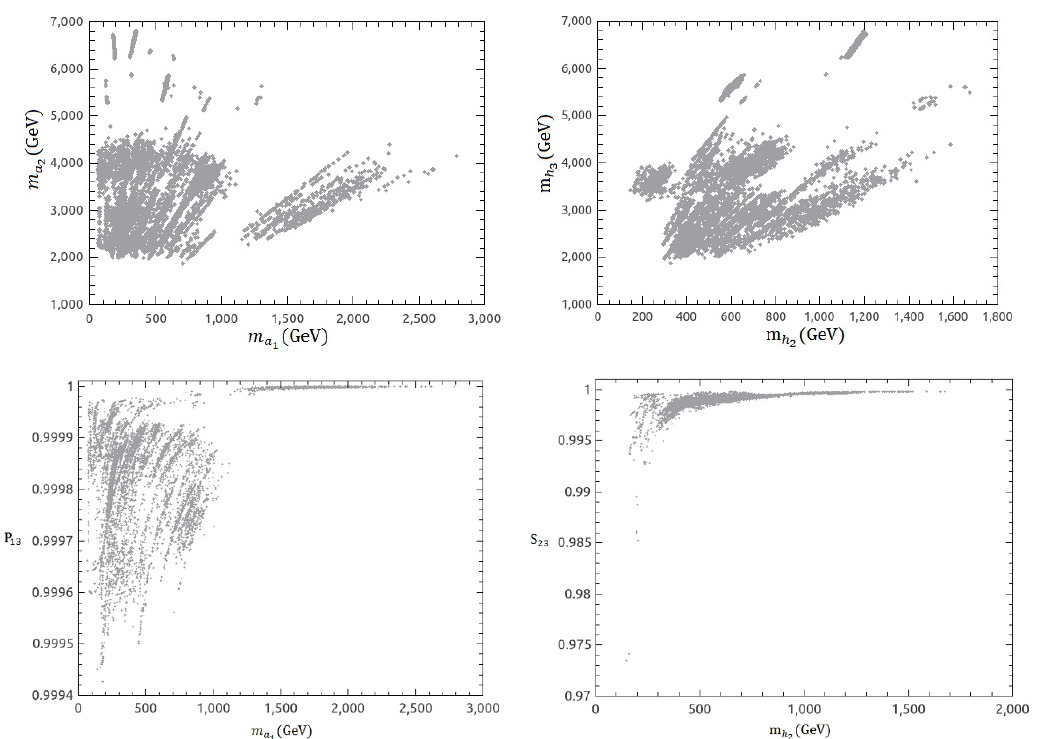
Figure 3 . In the upper panels are the scattering plots of m a (right). All survived points satisfy the LHC and EW precision measurement constraints as well as the required value of (cid:1) a (cid:22) to solve the muon g-2 anomaly. In the lower panels are the plots of the singlet components for a 1 (left) and H 2